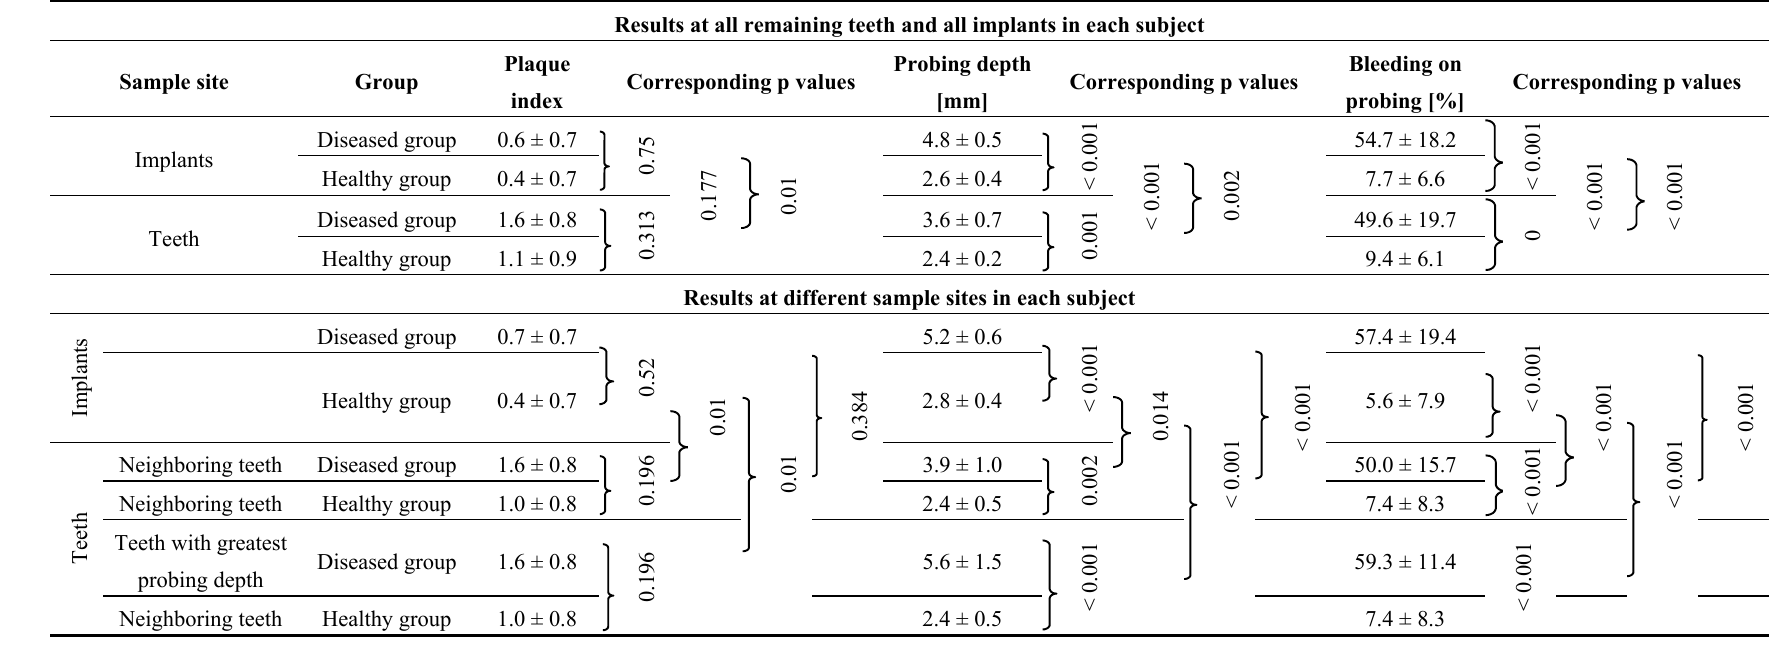
Neighboring teeth Healthy group Table 2. Patients with signs of periodontitis/peri-implantitis: plaque index, probing depth and bleeding on probing at implant or tooth sites (mean and standard deviation) and corresponding p values. Results at all remaining teeth and all implants in each subject Sample site Plaque index Corresponding p values Bleeding on probing [%] Corresponding p values Remaining teeth Implants Results at different sample sites in each subject Teeth with greatest probing